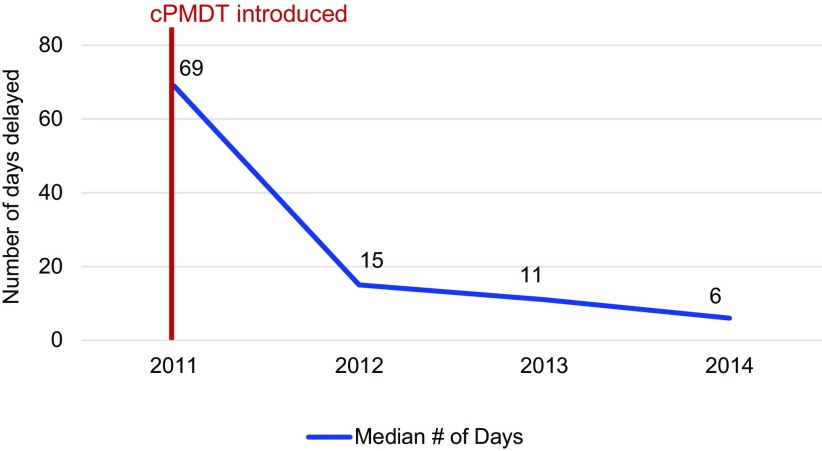
Trend in the Length of Delay Between DR-TB Diagnosis and Treatment Initiation, Bangladesh, 2011–2014Abbreviation: cPMDT, community-based programmatic management of drug-resistant tuberculosis; DR-TB, drug-resistant tuberculosis.